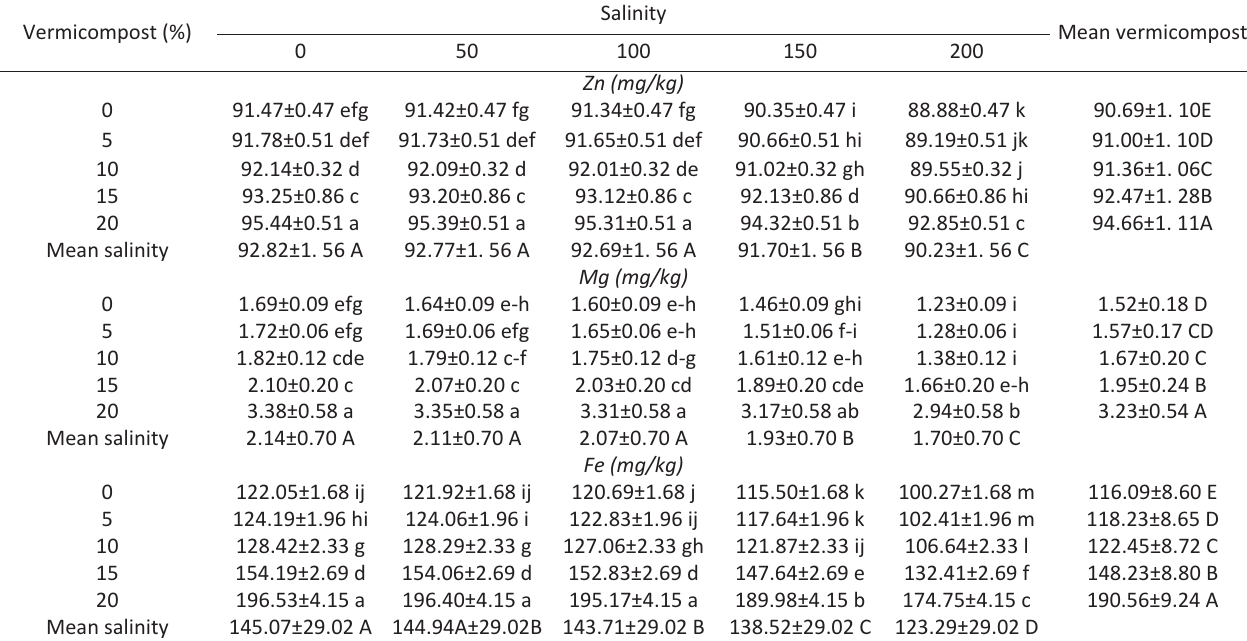
* In each variable, data followed by the same letters (small letters for interactions and capital letters for means) are not significantly dif- ferent using LSD at 5%level. Data represent the mean value ± S.D. the mean of